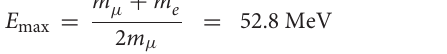
Frontiers in Physics |